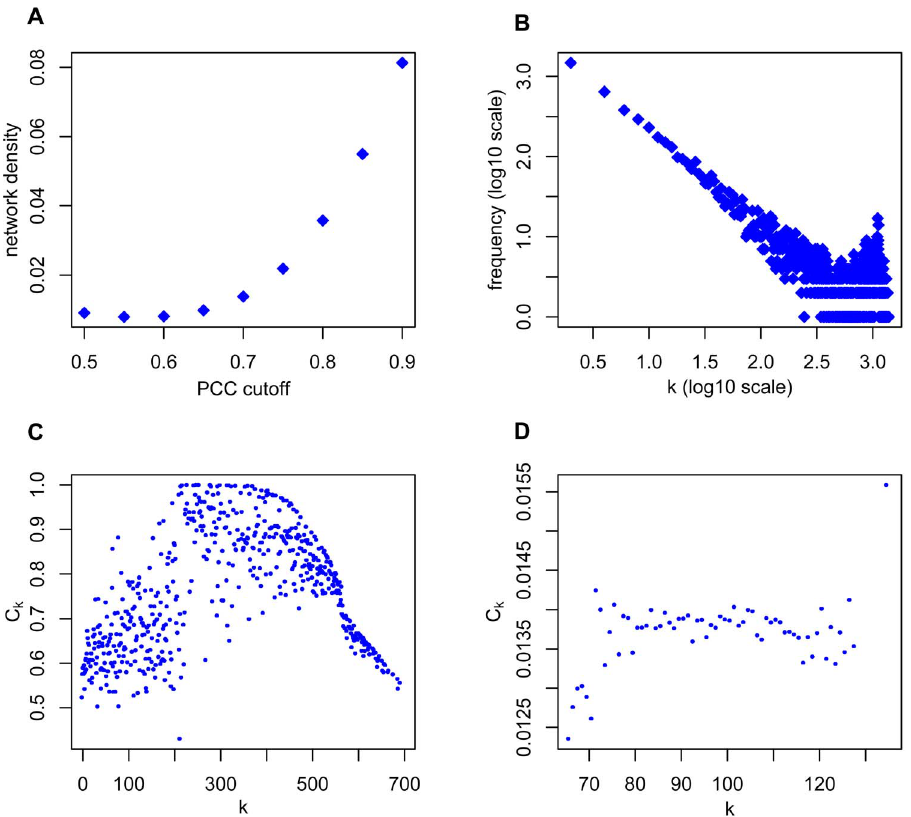
Figure 2. Properties of the PGCN. (A) Network densities at different PCC cutoff values. (B) Distribution of the node degree for PGCN. (C) The distribution of the clustering coefficient ( C k ) in relation to the node degree for PGCN. (D) The distribution of the C k in relation to the node degree for random network.